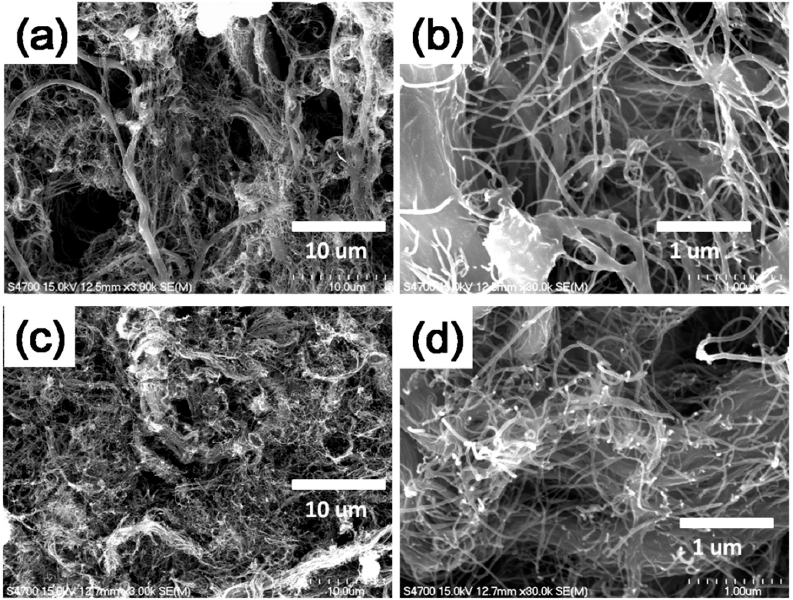
Figure 2. ( a ) Large-area scanning electron microscope (SEM) image of sample A. ( b ) Enlarged view of ( a ). ( c ) Large-area SEM image of sample B. ( d ) Enlarged view of ( c ). ( a ). ( c ) Large-area SEM image of sample B. ( d ) Enlarged view of ( c